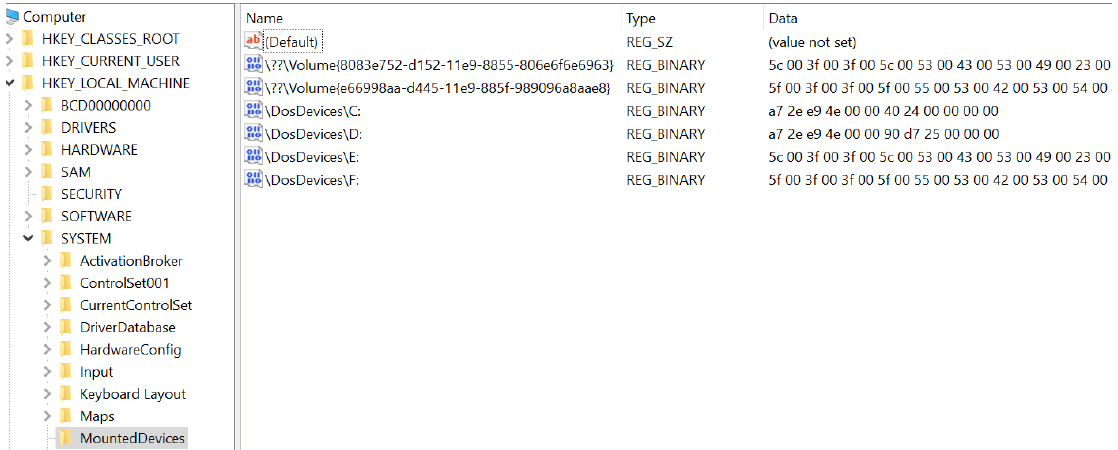
Figure 16. USB device information.